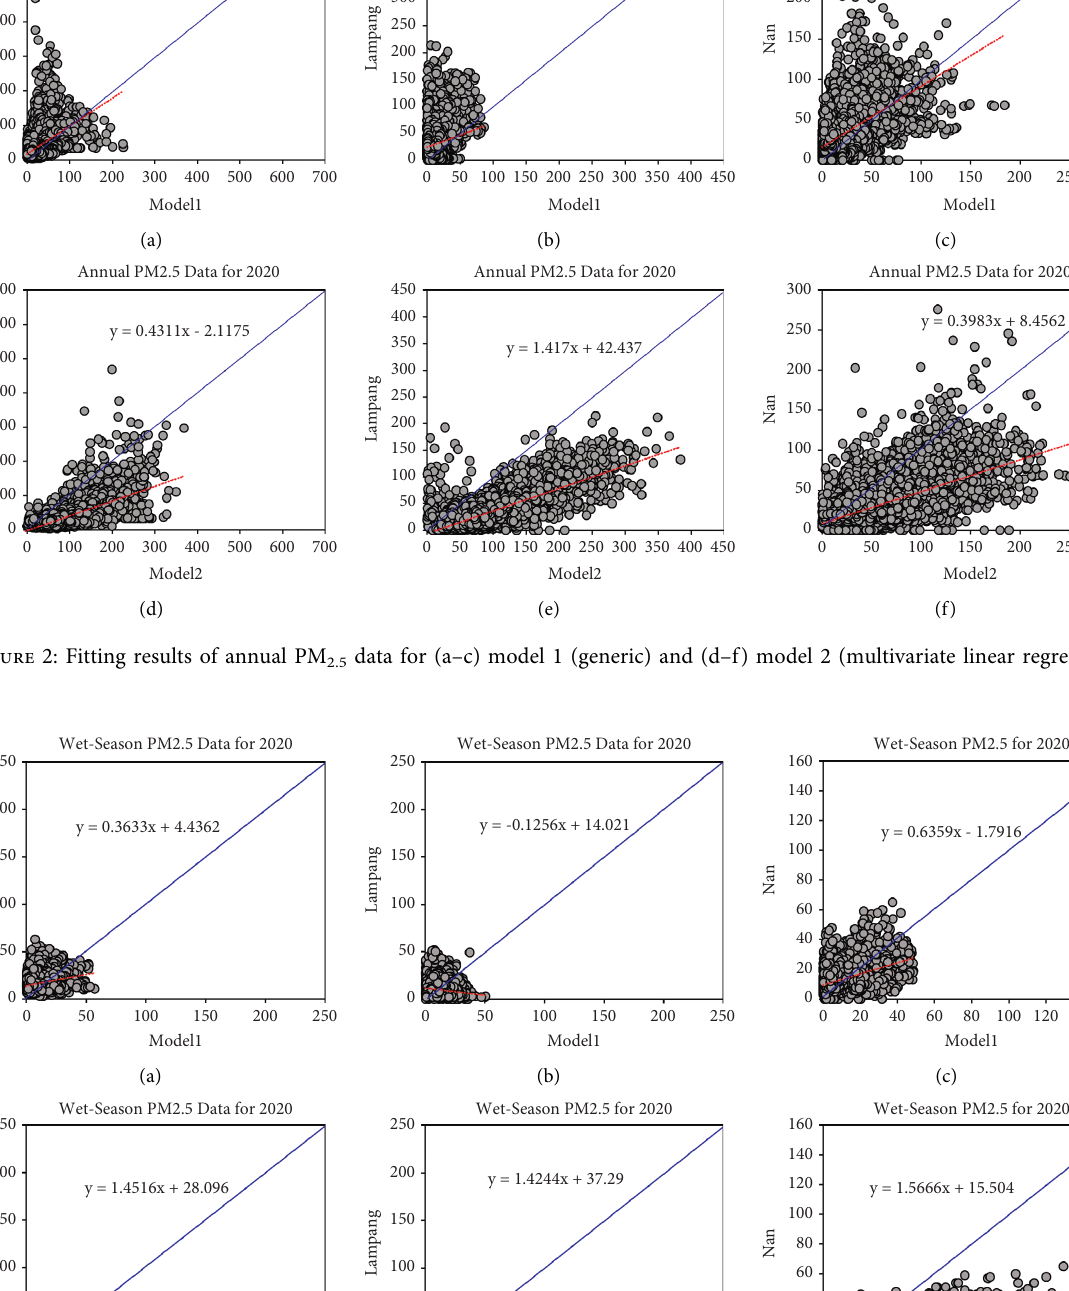
Figure 3: Fitting results of wet-season PM 2.5 data for (a–c) model 1 (generic) and (d–f) model 2 (multivariate linear